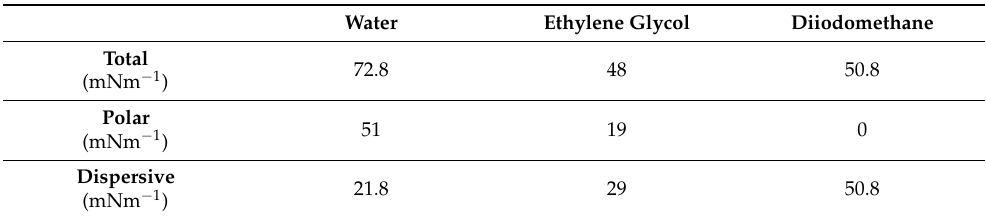
Figure A2. Measured CA of water in dependence on the dispense time. Table A1. Polar and dispersive components of the surface tension of water, ethylene glycol, and diiodomethane according to the WORK method [39].